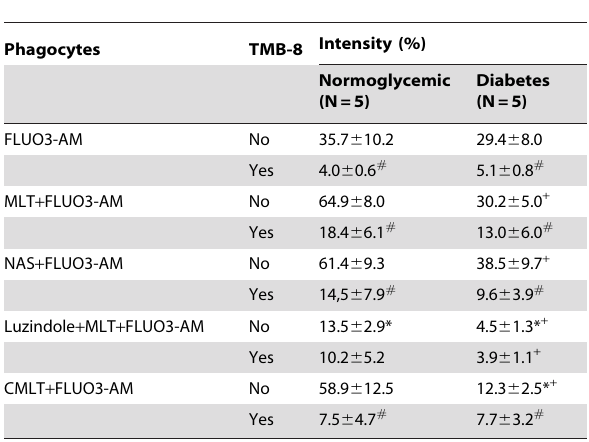
Table 2. Intracellular Ca 2 + release by mononuclear (MN) colostrum phagocytes from diabetic mothers indicated by fluorescence